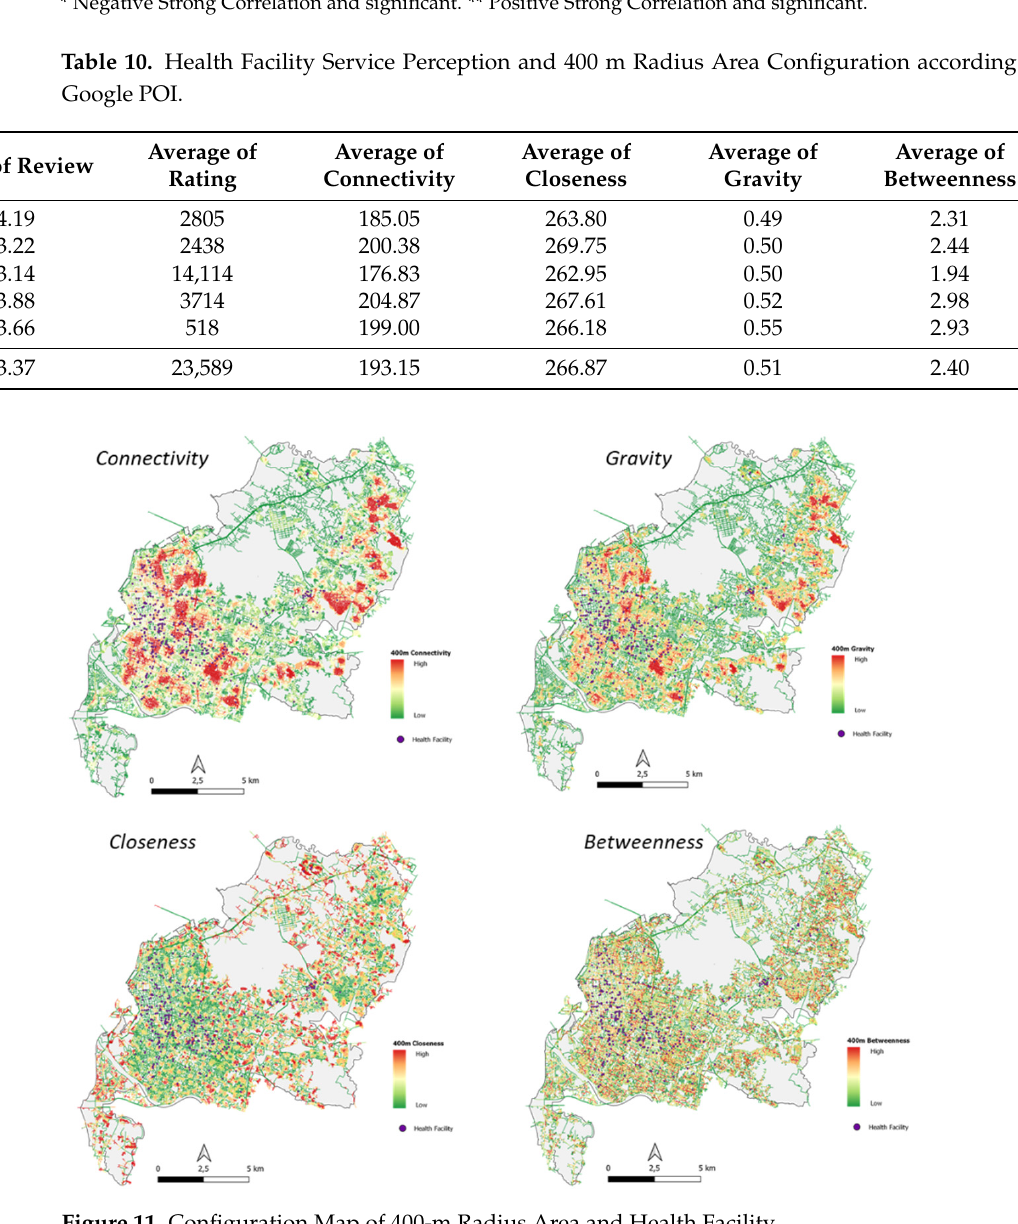
Figure 11. Configuration Map of 400-m Radius Area and Health Facility.